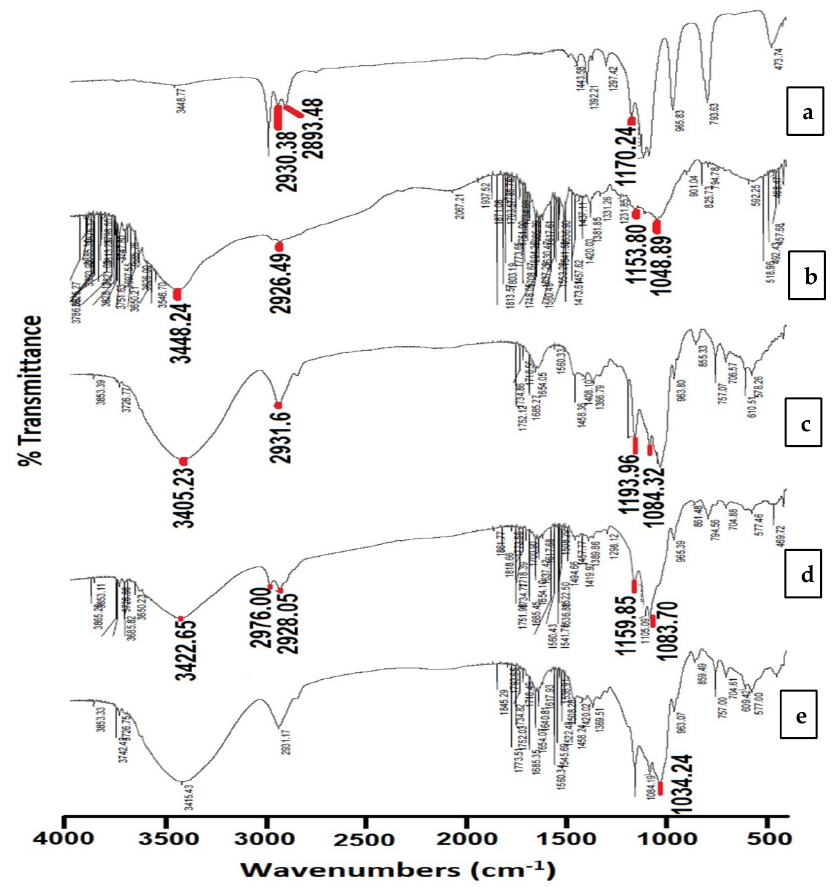
Figure 4. FTIR spectra for ( a ) TEOS, ( b ) chitosan HCl, ( c ) M β CD, ( d ) non-medicated physical mixture of SCM8–1 as well as ( e ) non-medicated SCM8–1.